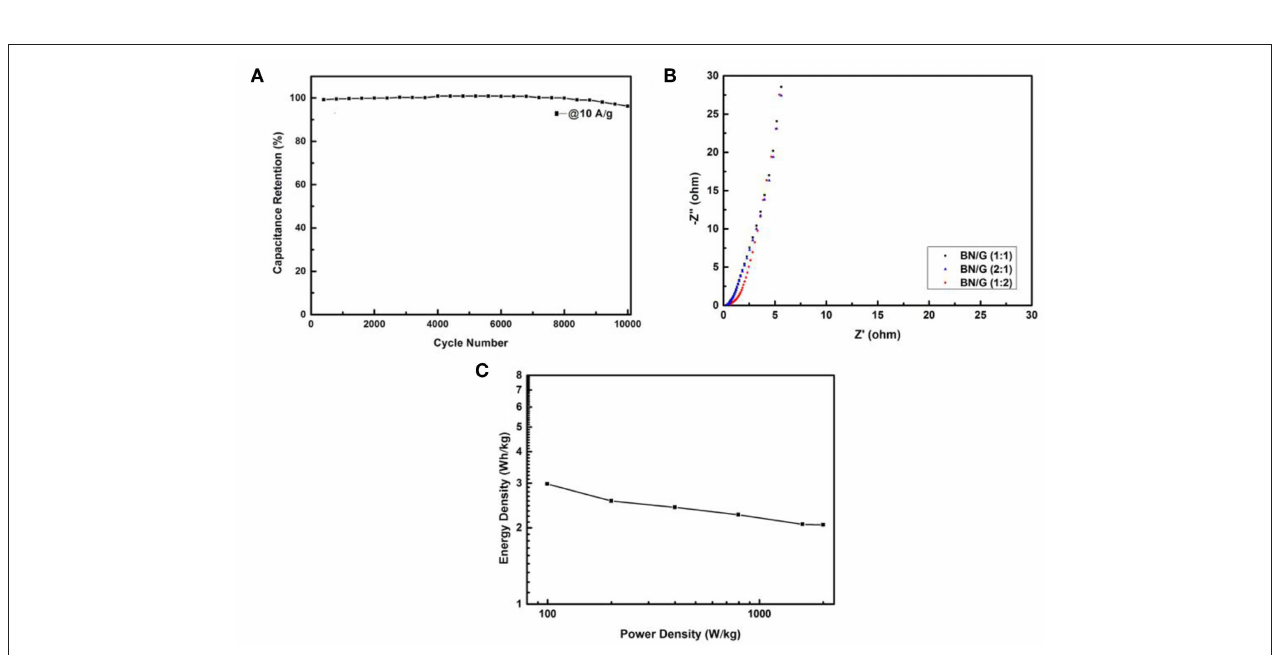
FIGURE 7 | Cyclic performances of the BN/G (1:2) after 10,000 cycles at 10 A/g (A) , Nyquist plots of all BN/G (B) , Ragone plots of the BN/G (1:2) (C) .